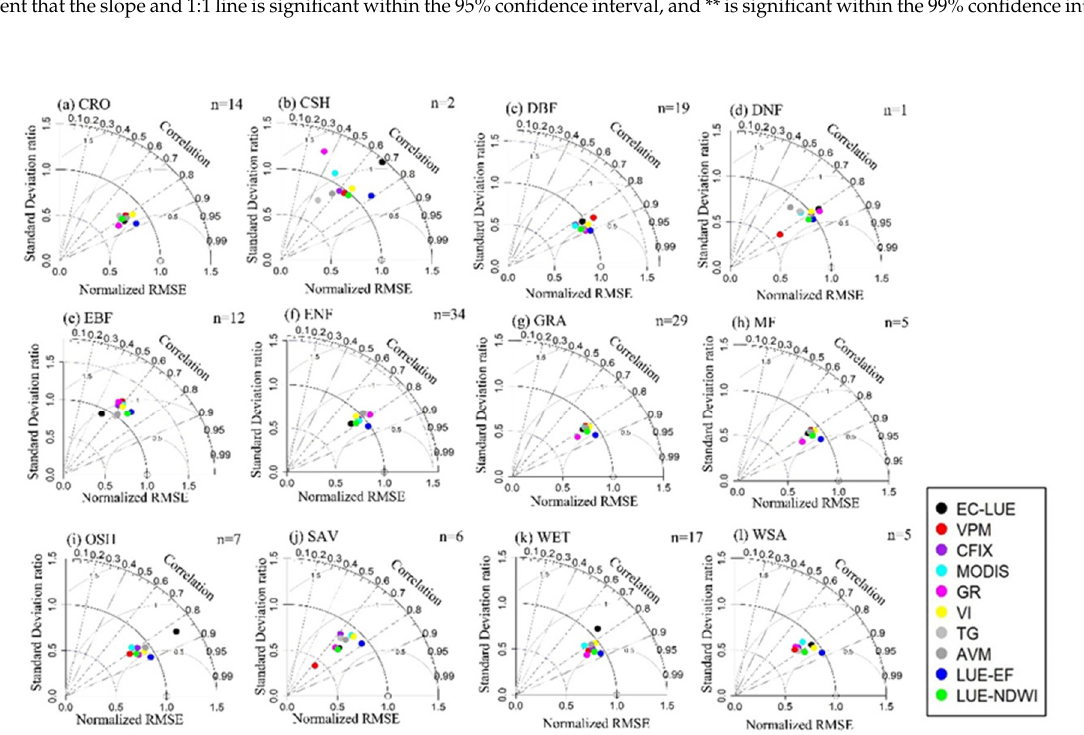
Figure 2. The comparison of remote sensing products data and ground EC-towers at site scale. The red dotted line is the 1:1 dotted line. Where (a) is CO2 (ppm), (b) is T ( ℃ ), (c) is LE (w/m2), (d) is H (w/m2), and (e) is NDWI. It's worth noting that the NDWI data is based on a spatial NDWI (500m resolution) and spatial NDWI (10km resolution) of different spatial resolutions.